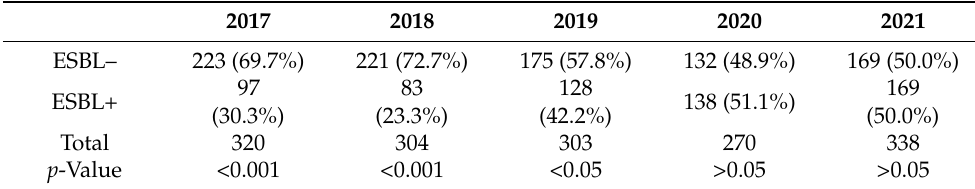
Figure 12. Comparison of the percentage of K. pneumoniae ESBL(+) and ESBL(−) strains from 2017 to 2021. Table 4. Number of K. pneumoniae ESBL(+) and ESBL(−) strains in 2017–2021.